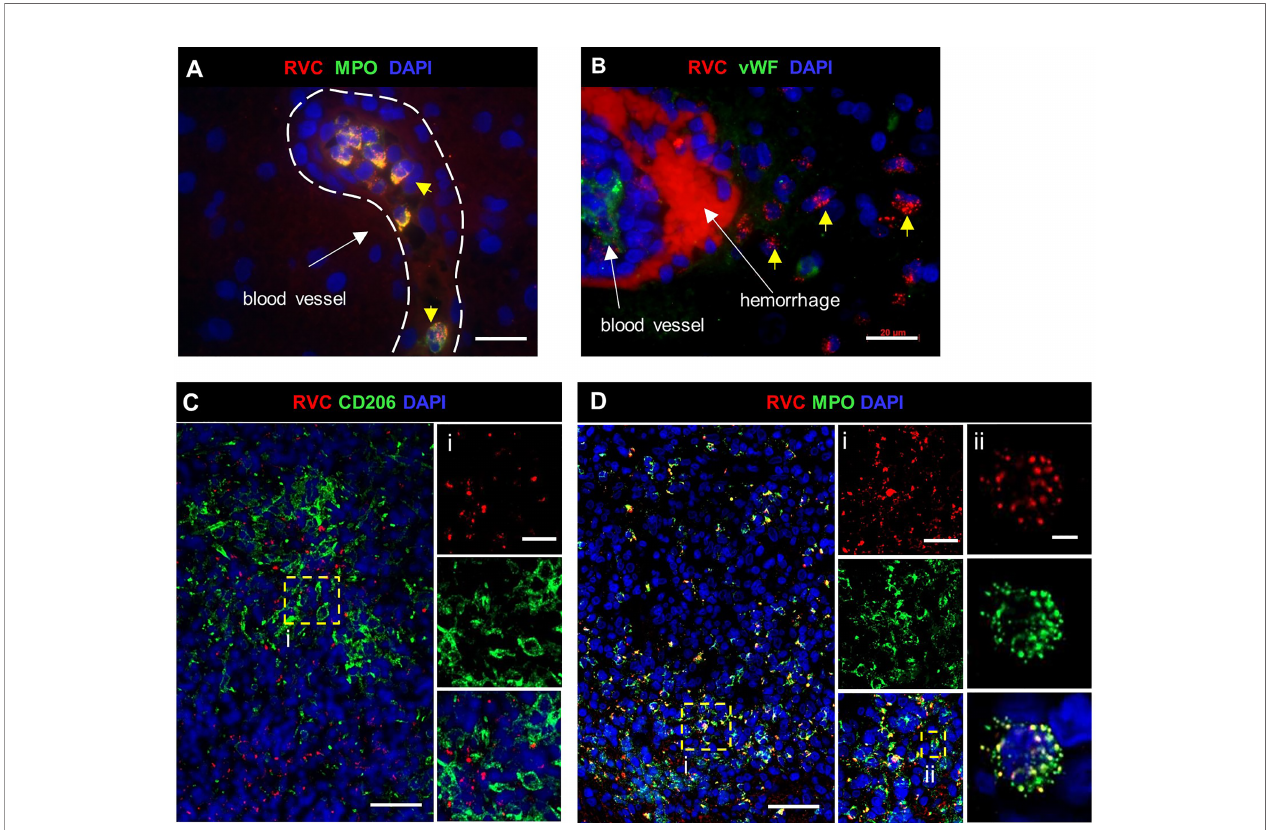
FIGURE 7 | RuV in brain neutrophils. Histological double immuno fl uorescent staining for RVC (A – D) and either MPO (A, D) , vWF (B) or CD206 (C) , showing RVC + neutrophils in the lumen of blood vessels, perivascular cuff, and around the area of hemorrhage (yellow arrows) in P12 brain (A, B) . Numerous RVC + neutrophils surrounding RVC - CD206 + granuloma in P27 brain (C, D) . Notice a colocalization of MPO granules with RVC (Dii) . Scale bars: 20 µm (A, B, Ci, Di) . 50 µm (C, D) , and 2 µm (Dii)